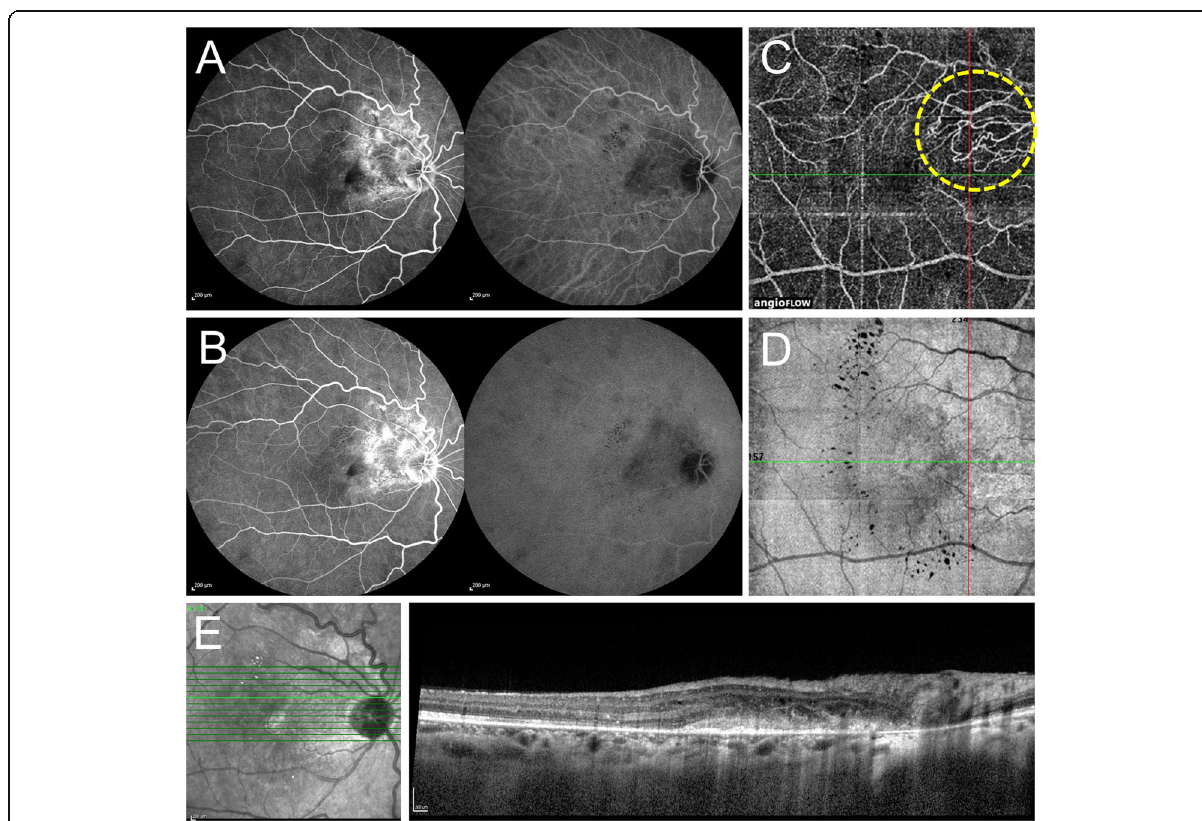
Fig. 2 Multimodal imaging in a case of peripapillary inflammatory choroidal neovascularization (CNV) (sea fan type). a Combined fluorescein angiography (FA) and indocyanine green angiography (ICGA) show multiple round hypofluorescent lesions in the mid-periphery with early ill-defined hyperfluorescence on FA and area of hypocyanescence with ill-defined choroidal vessels on ICGA temporal to the optic disc. b In the late phase FA, the mid-peripheral hypofluorescent lesions become less hypofluorescent/isofluorescent. There is a progressive increase in the hyperfluorescence temporal to the optic disc on FA, suggestive of type 2 choroidal neovascularization. c Optical coherence tomography angiography en face scan shows the presence of neovascular loops of vessels which have a sea fan configuration although the feeder vessel is not apparent (yellow dashed circle). The scan has been obtained by manually segmenting the image to obtain a slab of 60 μ m thickness including the outer retina and choriocapillaris to allow better delineation of the pathology. d The corresponding structural en face scan does not show any signal loss except in the areas of hard exudates. e The optical coherence tomography line scan passing through the area of CNV shows the presence of a hyper-reflective lesion in the outer retina in the peripapillary region suggestive of type 2 CNV associated with retinal thickening and intraretinal cystoid